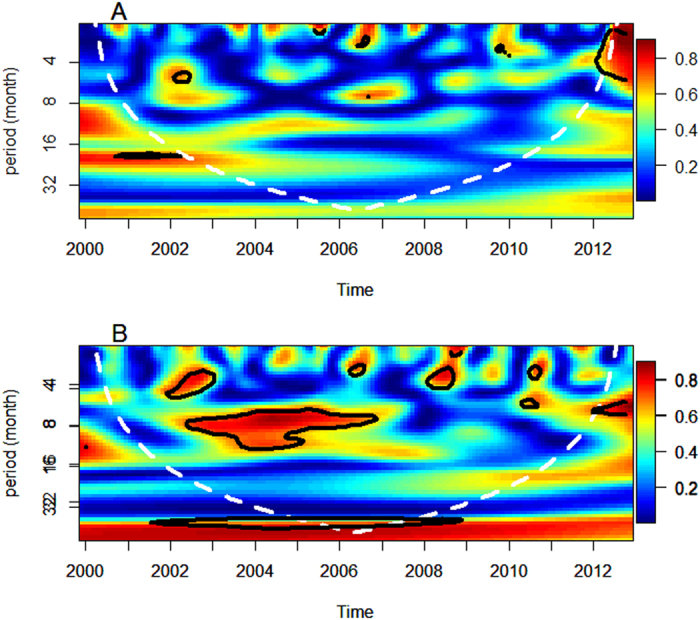
Squared coherence between Nino3.4, DMI and dengue incidence rate in Bangladesh (A: Nino3.4 and dengue, B: DMI and dengue).Statistical significance for coherence is determined by Monte Carlo simulations (300).Blue, low coherence; red, high coherence. The black lines show the areas where coherence is significantly high (95% confidence level). The cone of influence (white curve) indicates the region not influenced by edge effects.